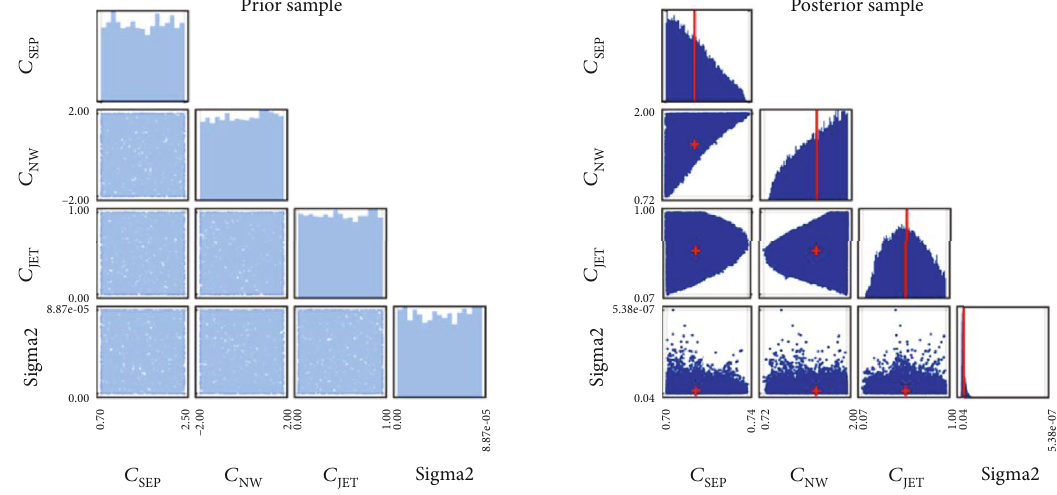
Figure 17: Prior and posterior distributions of RP (24-deg compression ramp). Table 11: Correlated model coe ffi cients corresponding to